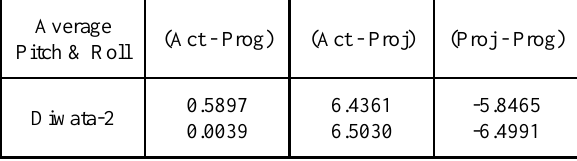
Table 5. Pitch/Roll averages for Diwata-2